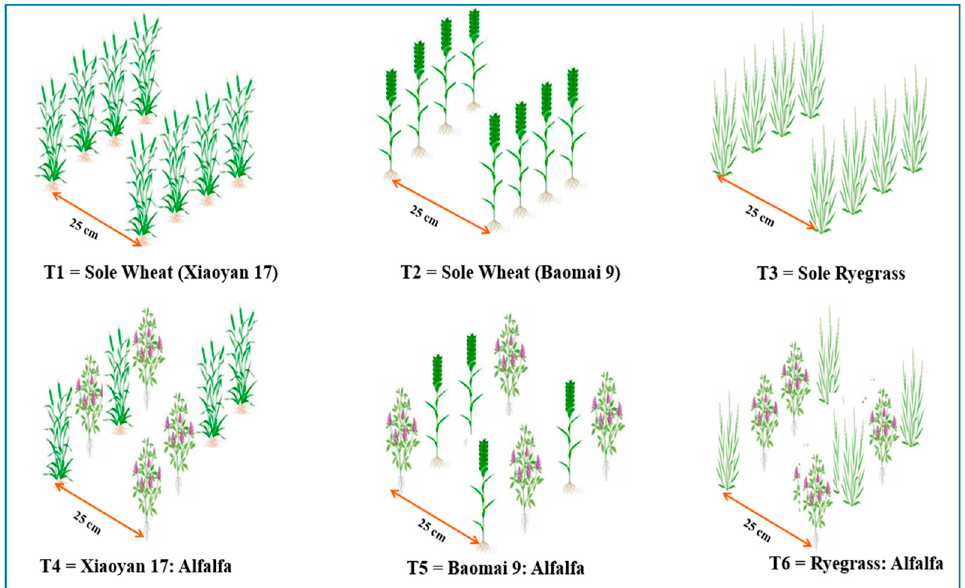
Figure 2. Schematic diagram of the sole cropping of winter wheat (Xiaoyan 17 and Baomai 9), sole cropping of ryegrass, winter wheat cultivar 1 (Xiaoyan 17)–alfalfa mixed cropping, winter